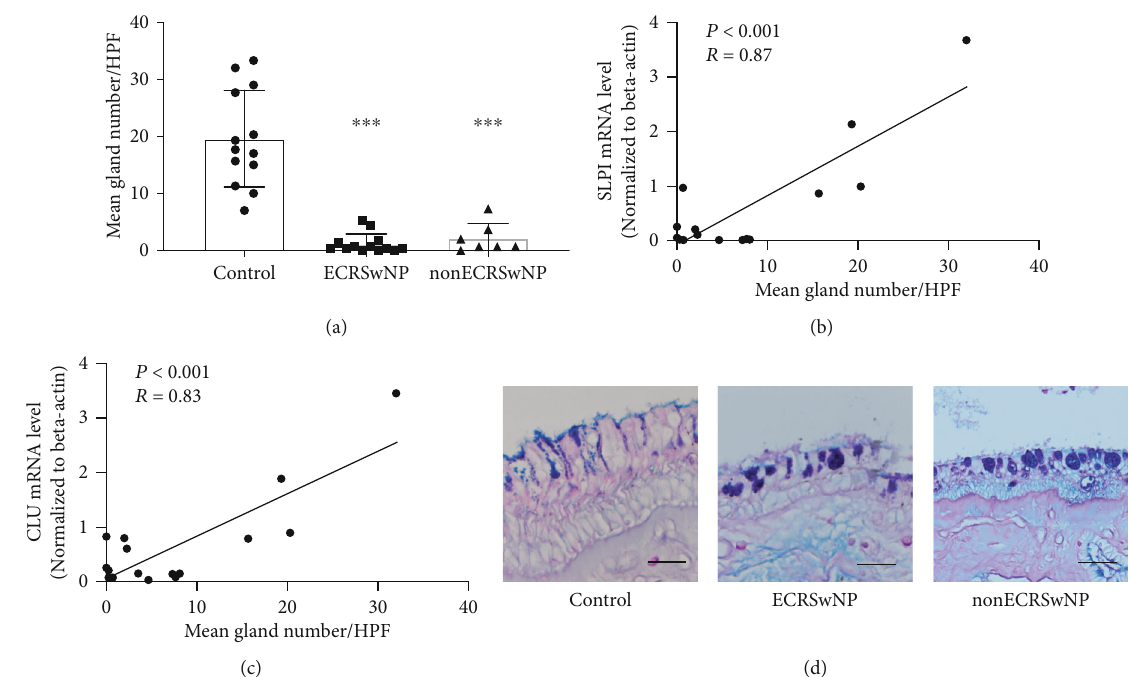
Figure 5: The expression of SLPI and CLU is correlated with the numbers of submucosal glands. (a) The number of submucosal glands per high power fi eld ( × 200 magni fi cations) in the nasal mucosa of ECRSwNP, nonECRSwNP, and healthy controls. (b, c) Correlations between the gland counts and the expression of SLPI and CLU. (d) AB/PAS staining shows goblet cell hyperplasia in the epithelial mucosa of ECRSwNP, nonECRSwNP, and healthy controls. Bars = 50 μ m. ∗∗∗ P < 0 : 001 . ECRSwNP: eosinophilic CRSwNP; nonECRSwNP: noneosinophilic